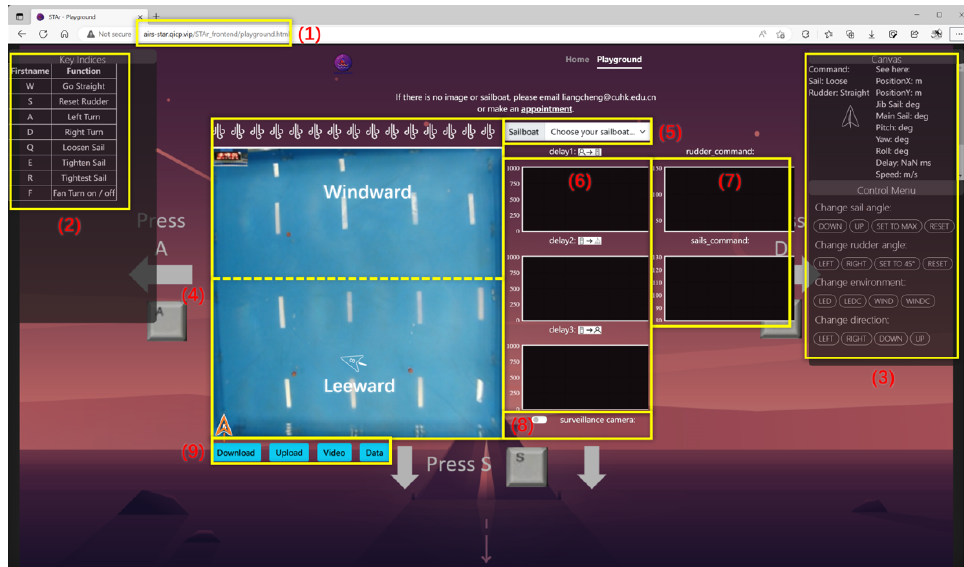
Figure 5. User interface of STAr. (1) The shared network address of STAr; (2) Key indices; (3) Infor- mation dashboard; (4) The pool region, wind direction, windward and leeward zones. (5) Selector for selecting a ready sailing robot. (6) Real-time display of delay. (7) Sail and rudder control com- mands. (8) Button for opening or closing the surveillance camera. (9) Buttons for remote